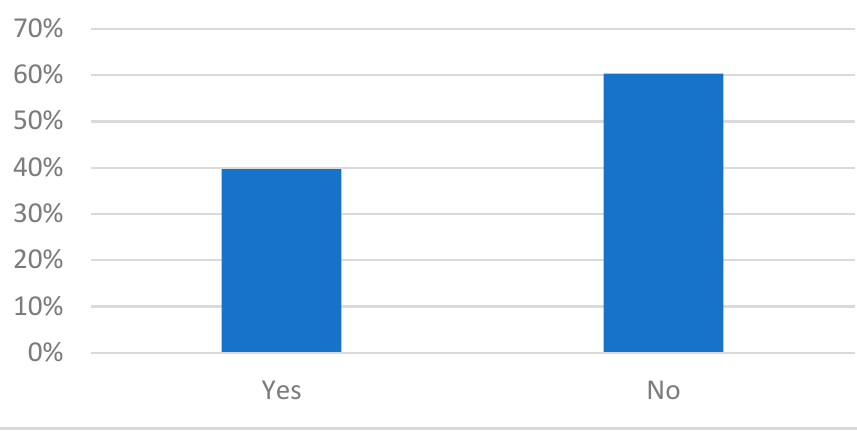
Figure 12. Have you experienced a surge in cyber attacks in your organization during the pandemic? (Asia and Europe).